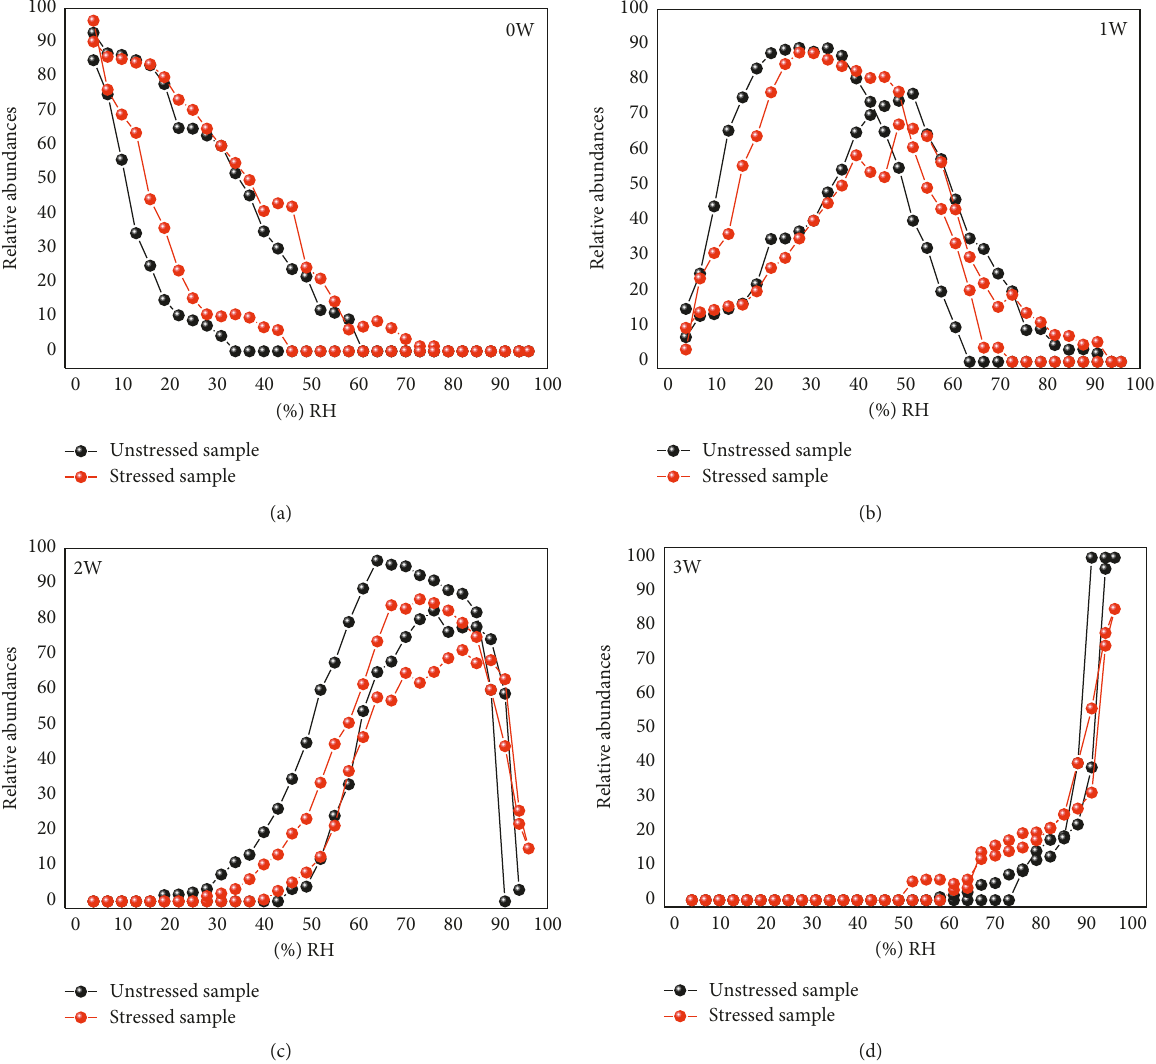
Figure 9: Evolution of the individual relative abundance of each hydration state as a function of the relative humidity (%RH) in the case of unstressed and stressed